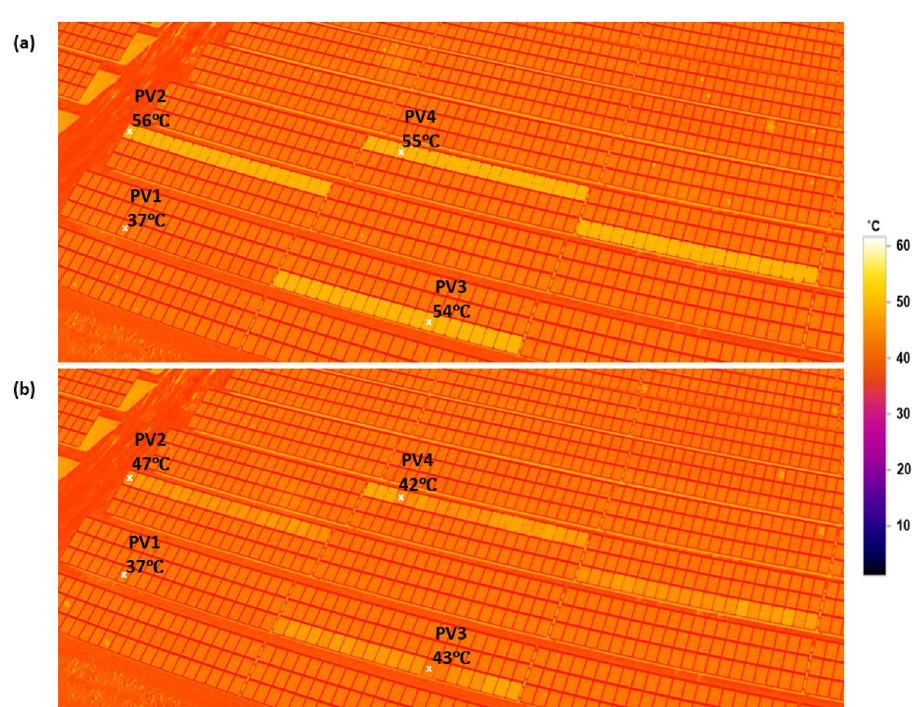
Figure 6. Thermography image of the tested PV strings during nigh-time. ( a ) Image taken on 03/08/2020, after one year of PV operation (ambient temperature 35 °C). ( b ) Image taken on 10/08/2021, after 1-year of fitting the anti-PID box on the PV strings (ambient temperature 35 °C). The thermal image is taken using DJI Mavic 2 Enterprise Advanced drone with thermal sensitivity ± 2 °C, the selected points on the figure are rounded to the nearest